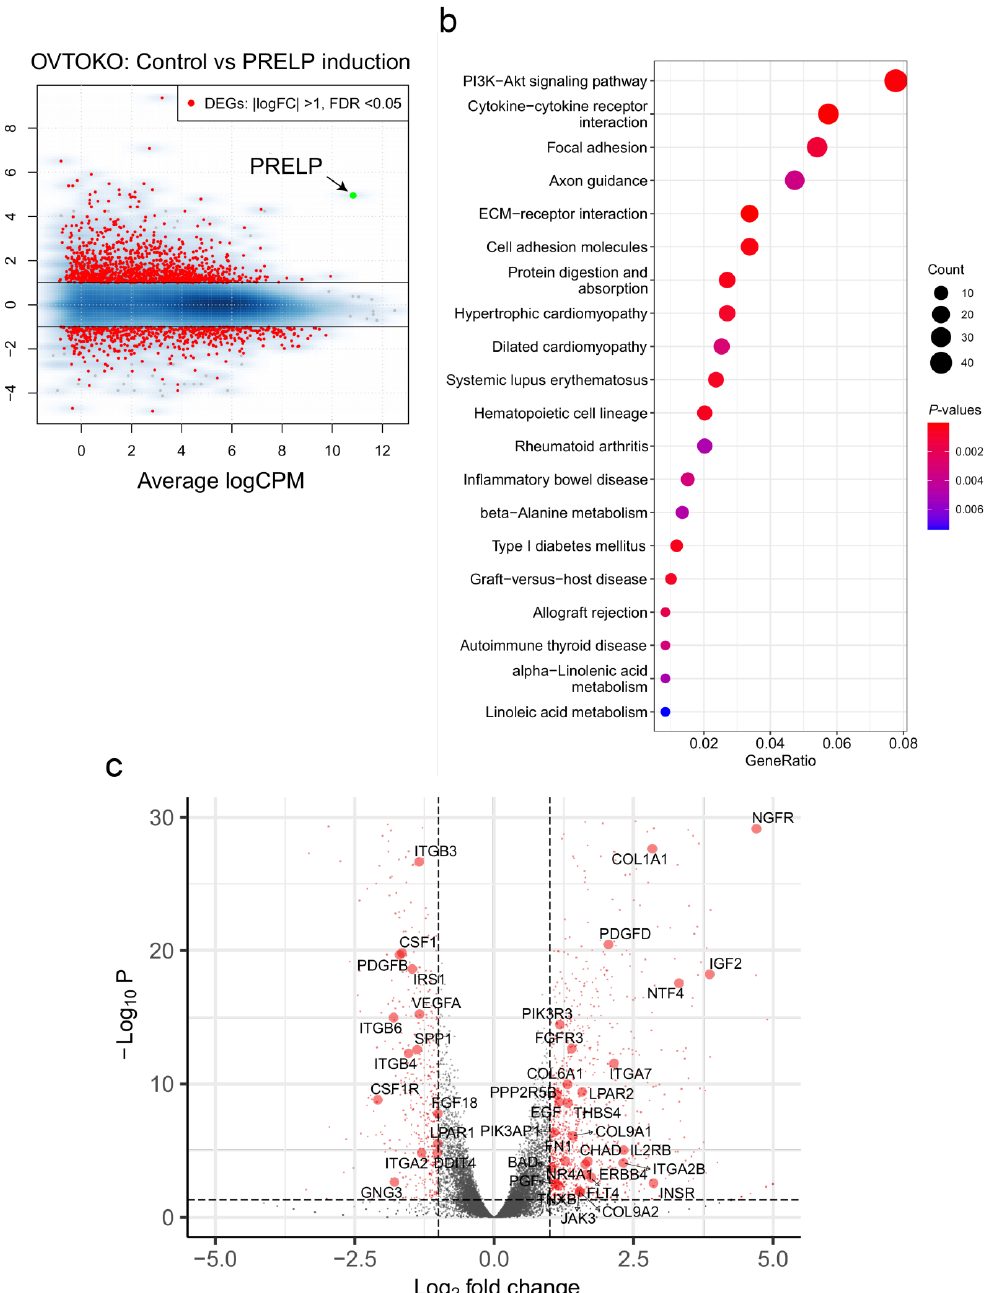
Figure 5. PRELP regulates the PI3K-AKT signaling pathway. ( a ) MA plots illustrating differentially expressed genes (FDR < 0.05, |logFC| > 1, red dots) between conditionally expressed OVTOKO cells with ( n = 3) and without DOX ( n = 3). The overexpression of PRELP is shown as green dots. The average logCPM is plotted on the x-axis. The logFC is plotted on the y-axis. ( b ) KEGG pathway enrichment analysis of differentially expressed genes in OVTOKO cells that overexpressed PRELP. Dot plot showing GeneRatio on the x-axis and terms sorted by GeneRatio on the y-axis. The p -value is displayed as a gradient from red to blue. The number of counts is indicated by the size of the black circle. ( c ) Volcano plots illustrating differentially expressed genes (FDR < 0.05, |logFC| > 1, red dots) between the same set of OVTOKO cells as ( a ). Differences in Log 2 fold change in gene expression values are plotted on the x-axis. Adjusted p -values calculated using the Benjamin–Hochberg method are plotted on the y-axis. Genes corresponding to the PI3K-AKT signaling pathway are shown as large red